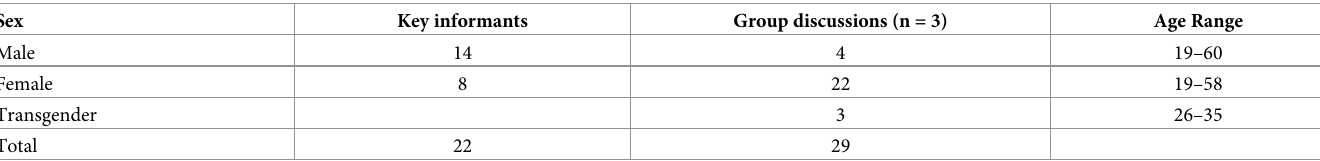
Table 2. Study participant’s gender and age.